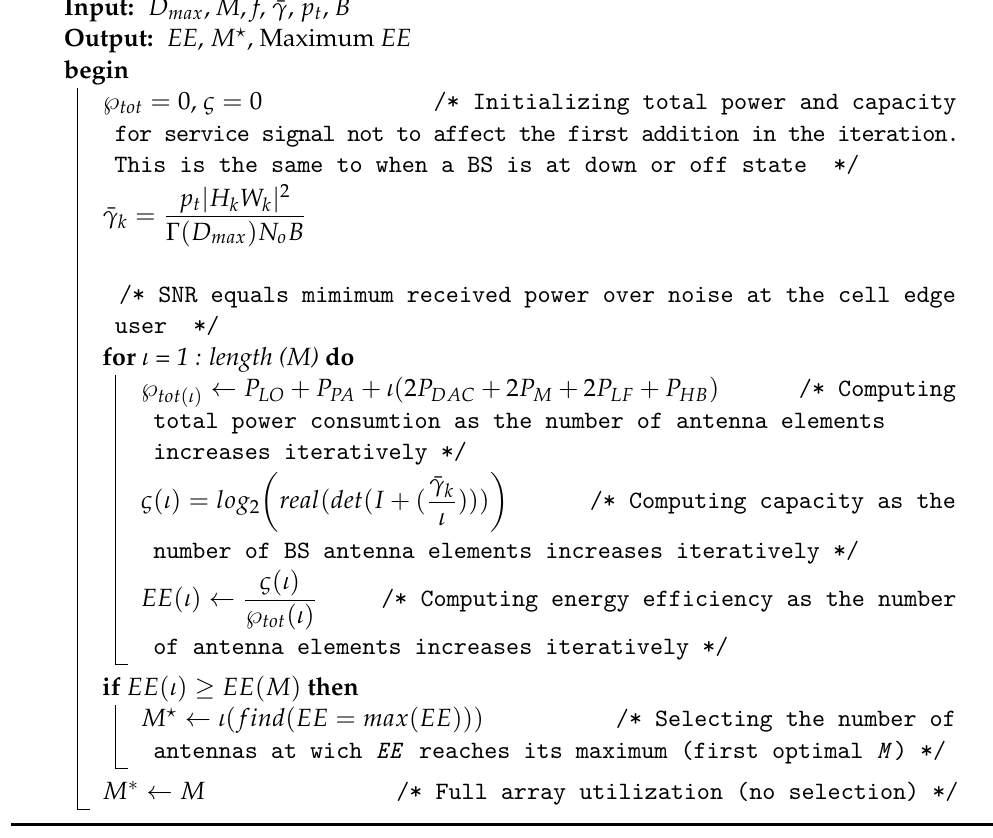
Algorithm 1: Initial access-based optimal number selection